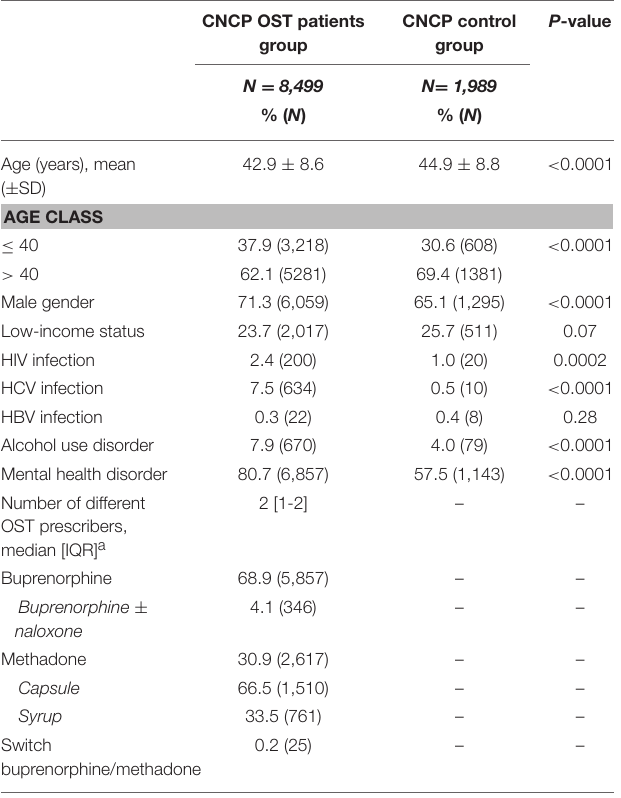
TABLE 1 | Comparison of characteristics between CNCP OST patients group and CNCP control group in 2015.